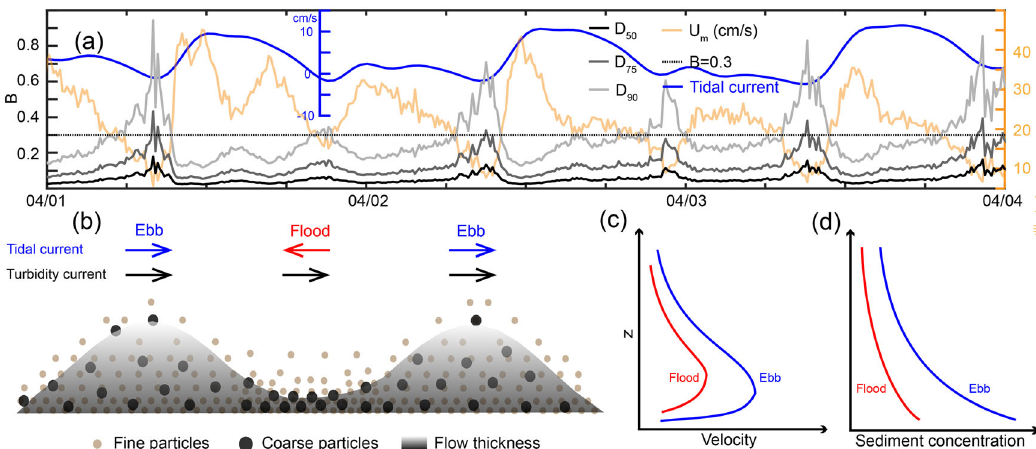
Fig. 8 Tidal modulation of weak turbidity current E1. a Variations of the Rouse-based criteria B computed from different grain sizes ( D 50 , D 75 , and D 90 ). The orange line and blue line are the vertical maximum velocity ( u M ) and tidal current (positive value is ebb phase). b The sketch map of tidal modulation of weak turbidity current. The shadow indicates the depth-averaged fl ow thickness. The brown and black dots denote the fi ne and coarse particles, respectively. c and d Conceptual vertical velocity and sediment concentration pro fi les of E1 during the fl ood (red) and ebb (blue)